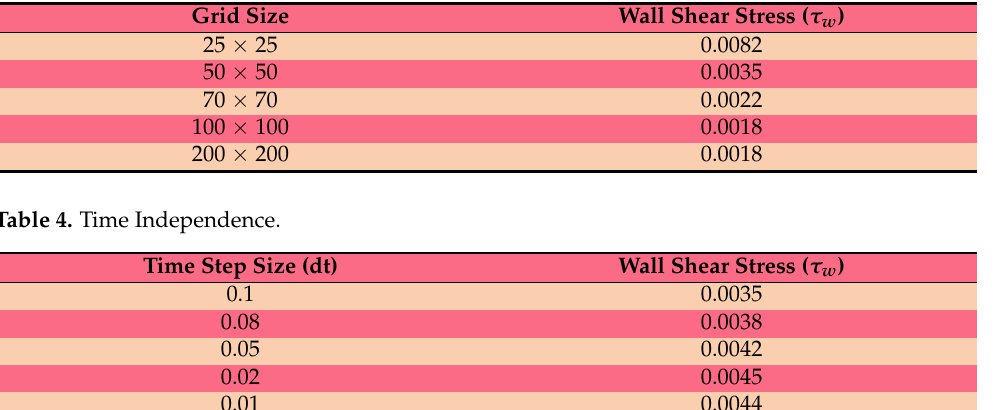
Table 3. Grid Independence.